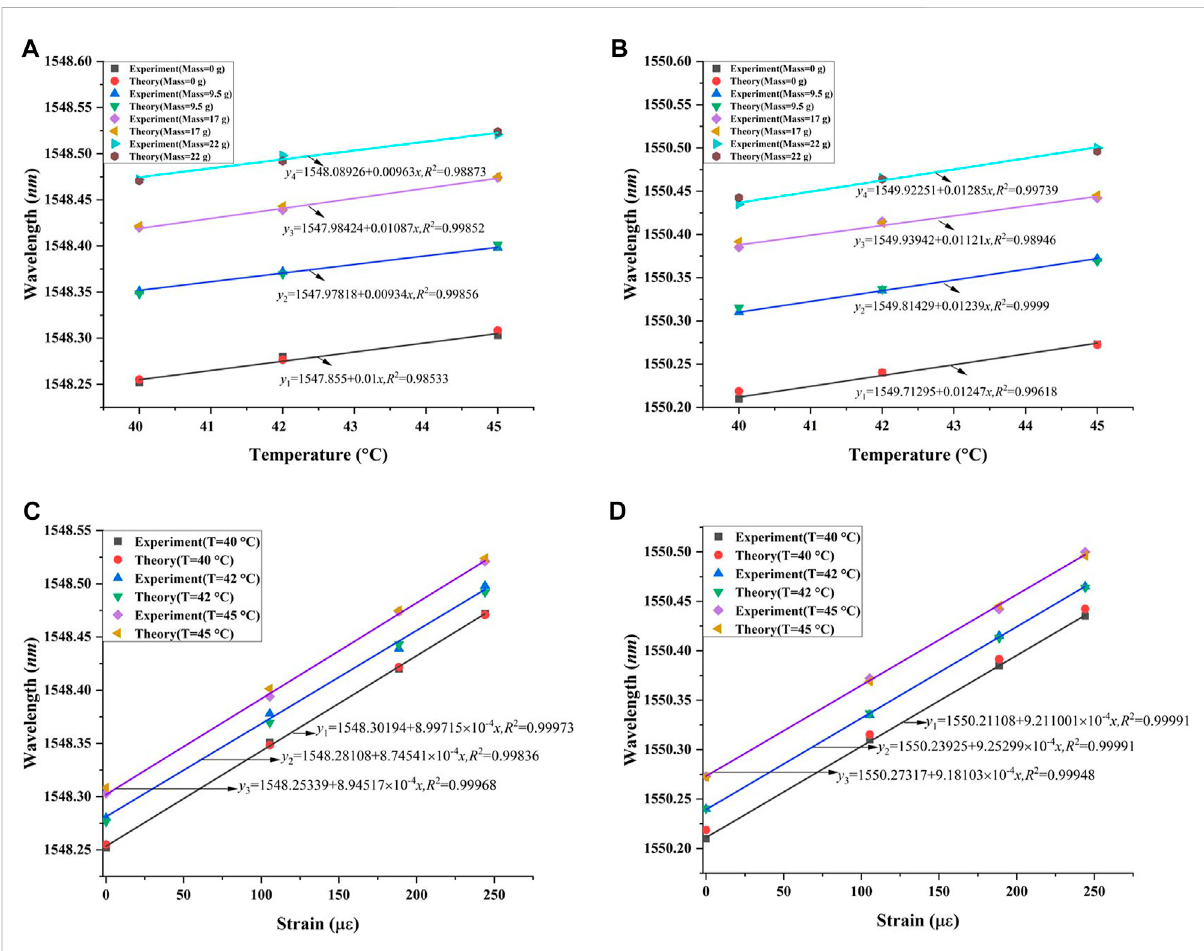
FIGURE 8 Results of the veri fi cation experiment on the cross sensitivity between temperature and strain. (A) Comparison of theoretical and experimental data and curve fi tting results obtained from experimental data under the same strain at 1,548 nm . (B) Comparison of theoretical and experimental data and curve fi tting results obtained from experimental data under the same strain at 1,550 nm . (C) Comparison of theoretical and experimental data and curve fi tting results obtained from experimental data under the same temperature at 1,548 nm . (D) Comparison of theoretical and experimental data and curve fi tting results obtained from experimental data under the same temperature at 1,550 nm